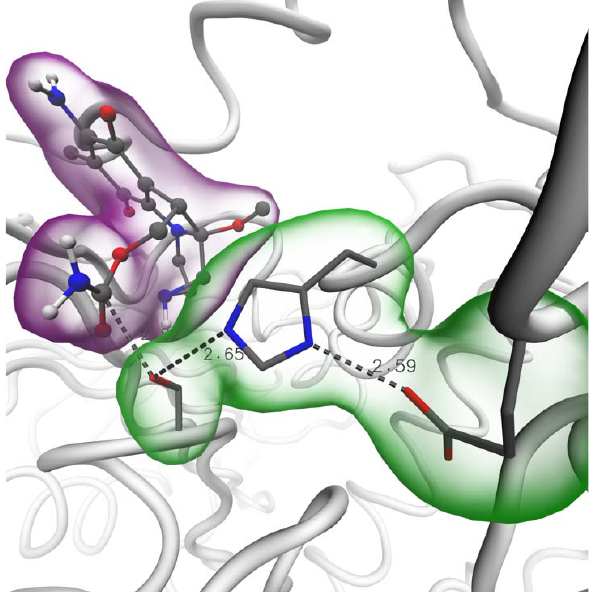
Figure 7. Model complex of Mitomycin approaching the catalytic triad in AChE (Ser200, His440, Glu327, in green).